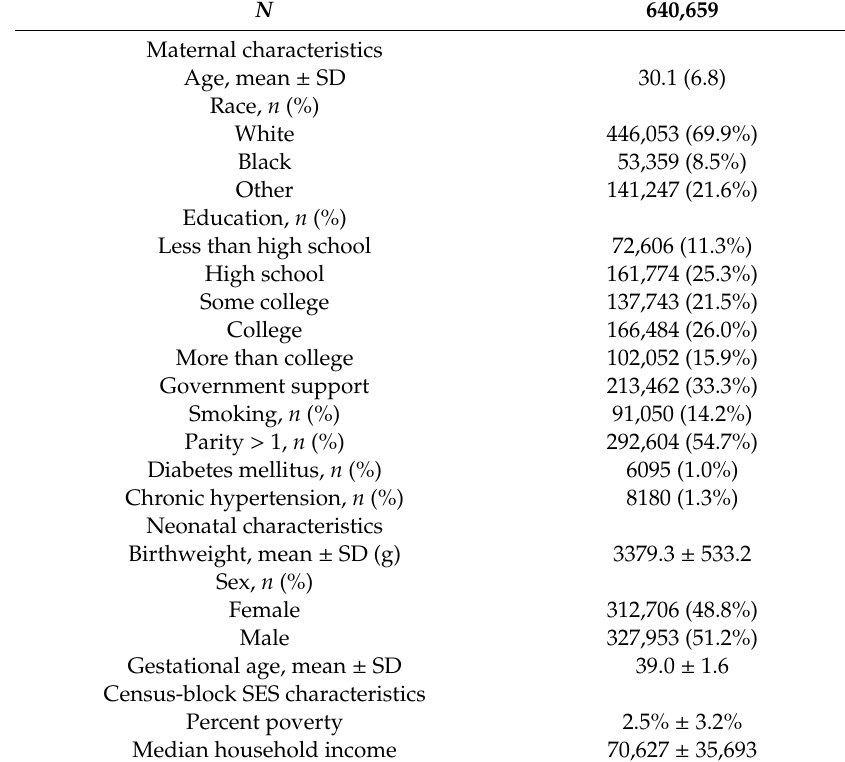
Table 1. Maternal and neonatal characteristics of women who gave birth in Massachusetts between 2001 and